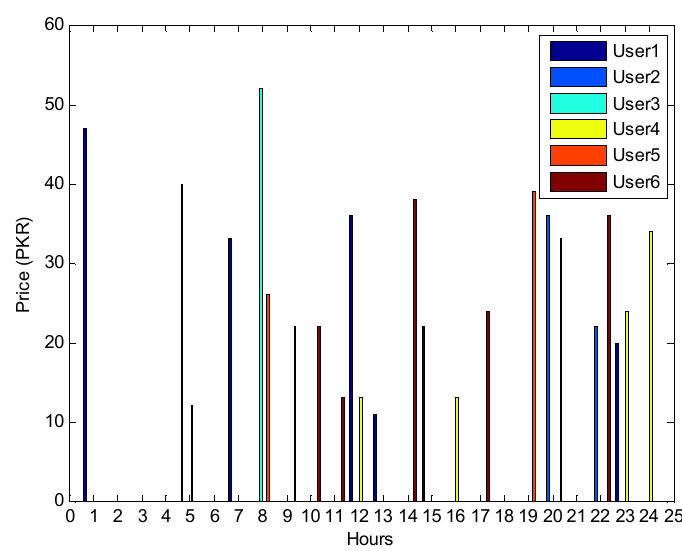
Figure 6. Shortage and surplus energy after the optimization.